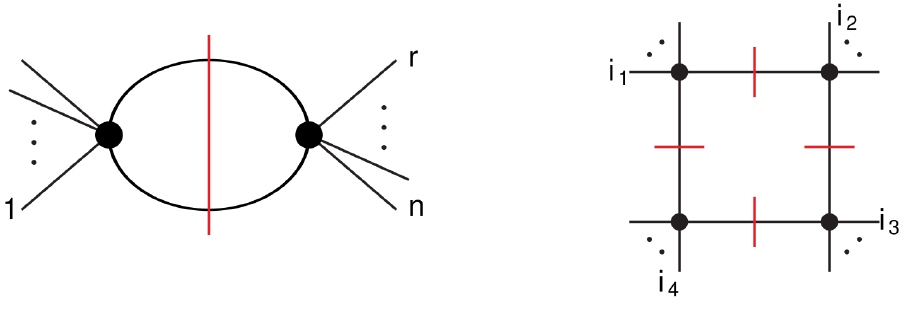
Figure 1: Unitarity cut constructions build loop amplitudes from tree amplitudes, and this is particularly effective with the maximal supersymmetry of N = 4